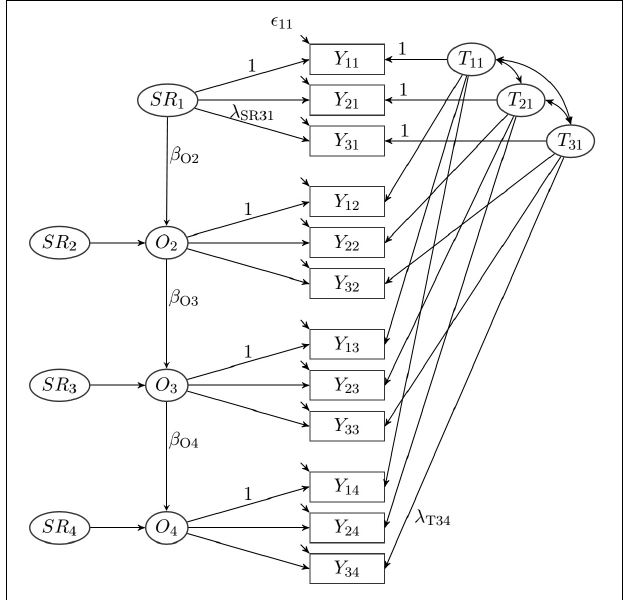
FIGURE 1 | Latent state-trait model with autoregressive